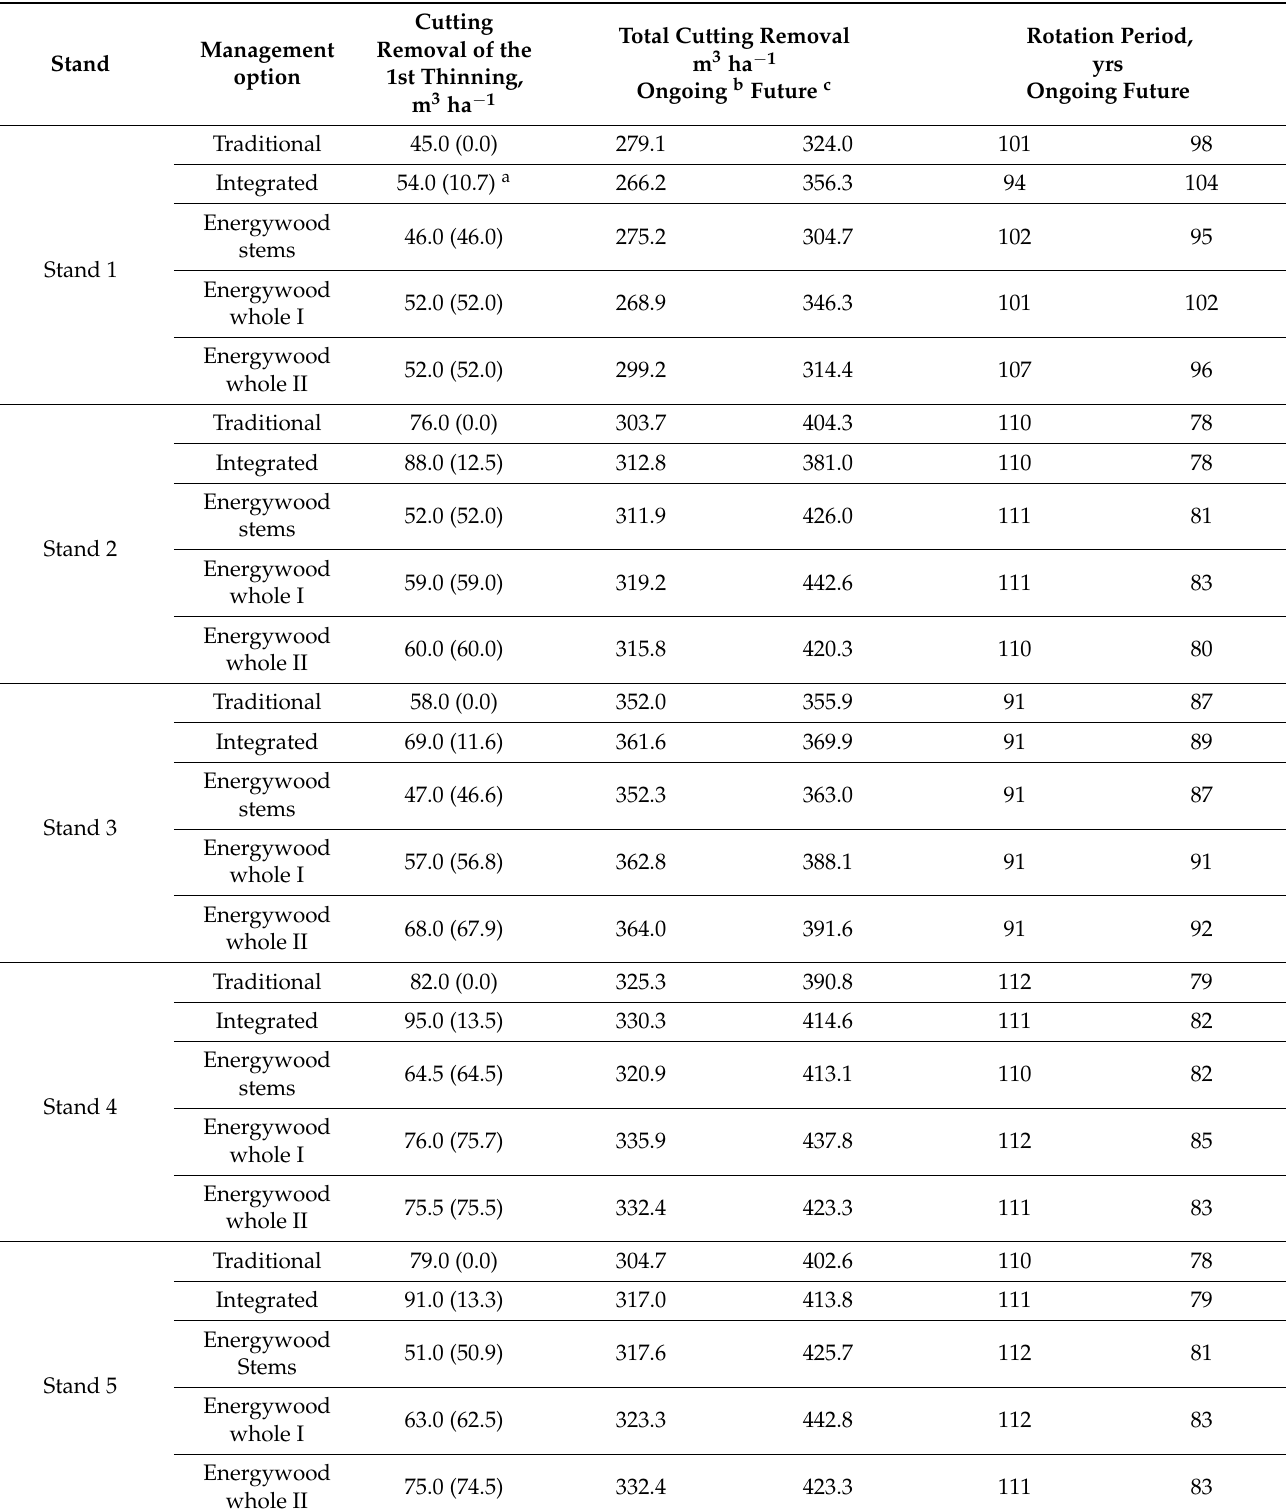
Table 4. Thinning removal of the first thinning. Total cutting removal and rotation period associated with optimal solutions according to management options. Total cutting removal and rotation period associated with future generations also shown. Stand-level optimizations simulated with 3% interest